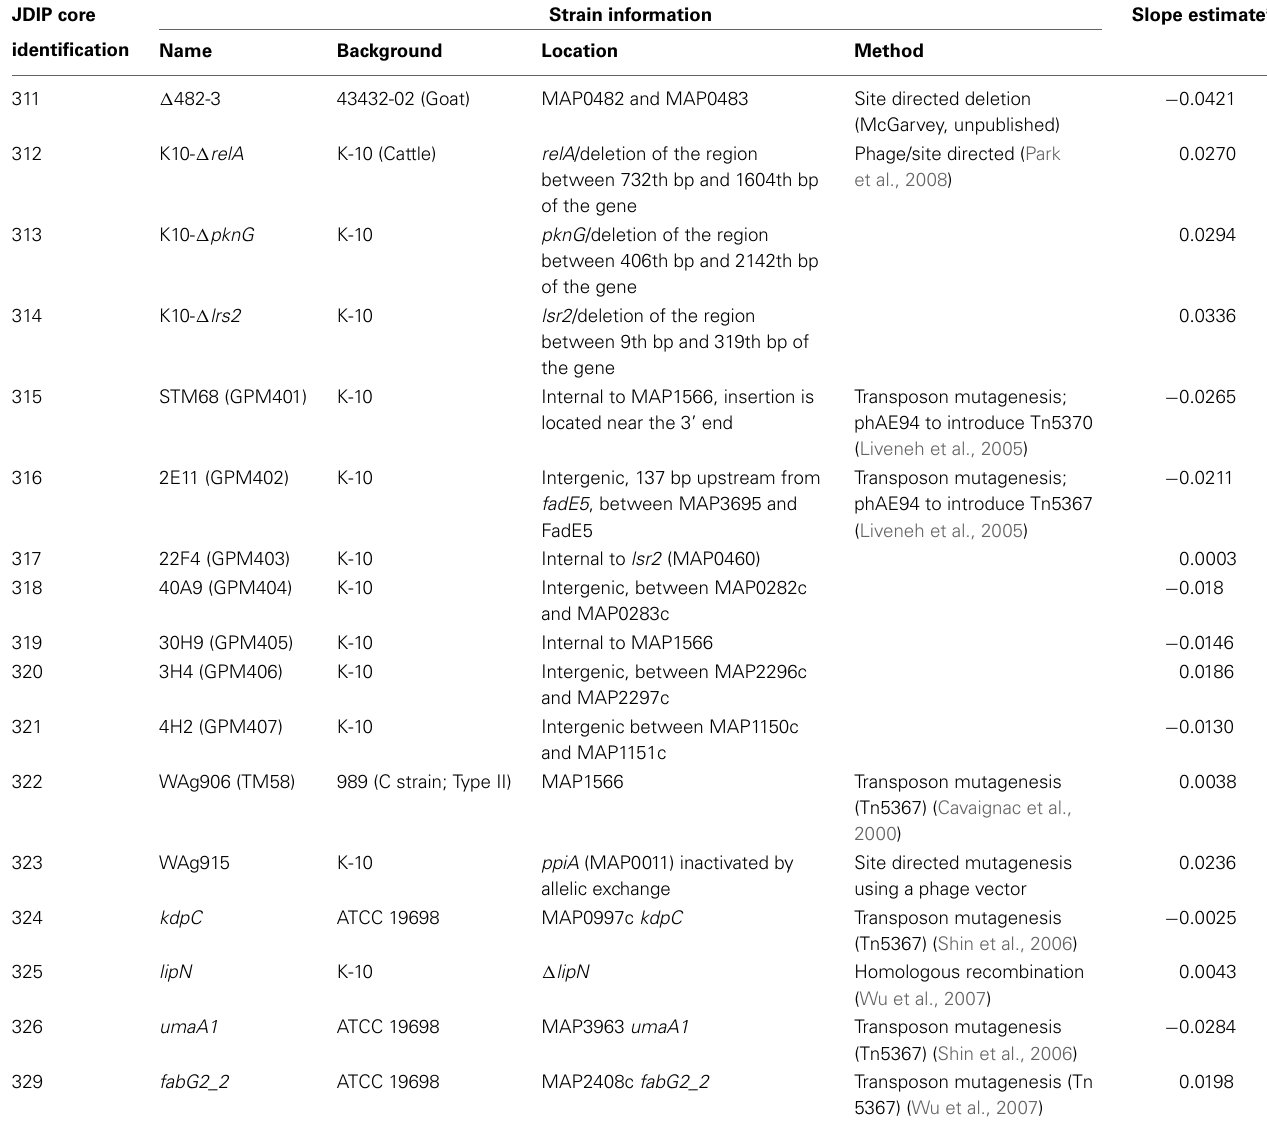
Table 1 | MAP mutant identification, strain information, and slope